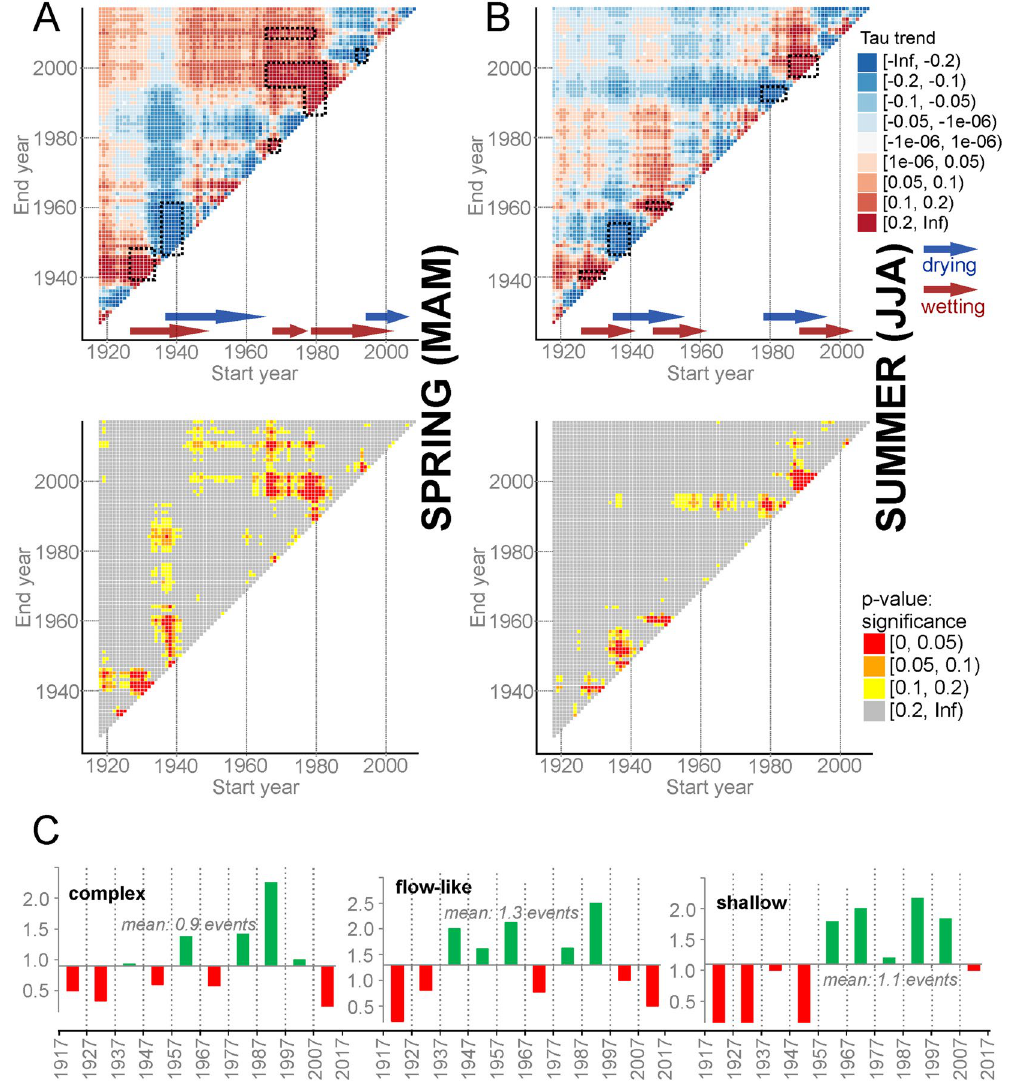
Figure 5. Comparison of precipitation trends with frequency of landslide activity. Decadal trends of spring ( A ) and summer precipitation ( B ) with significance levels based on the Mann-Kendal trend test (black-bordered polygons show the most significant drying or wetting periods); ( C ) decadal frequency of landslide activity based on landslide